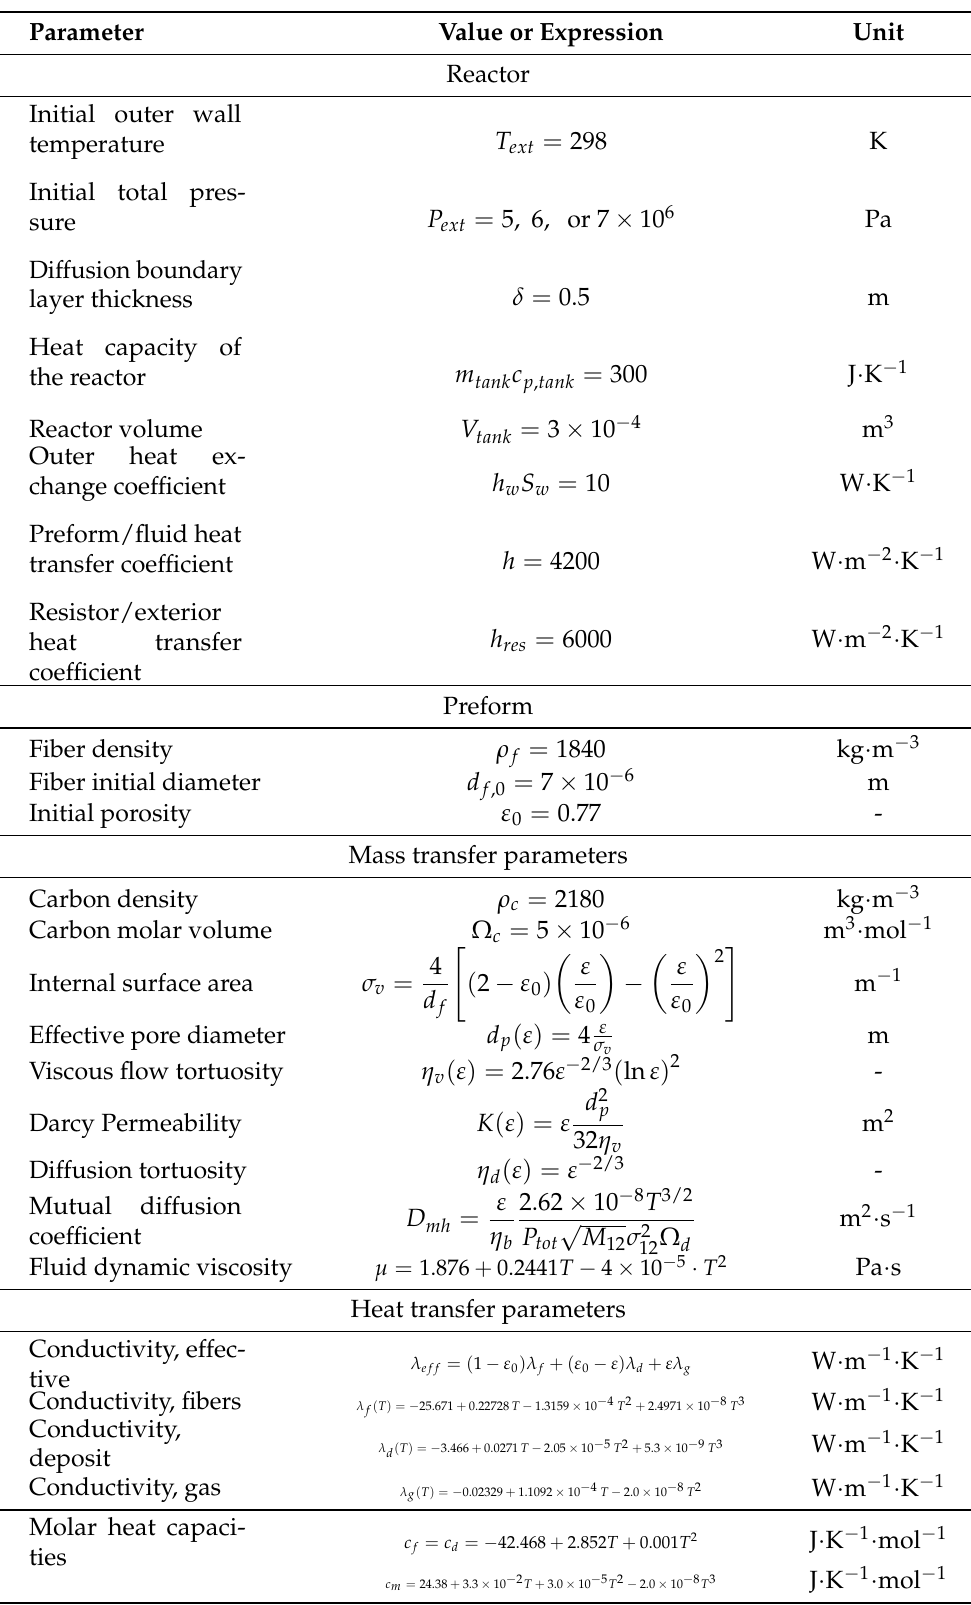
Table 4. Physical parameters employed in the numerical